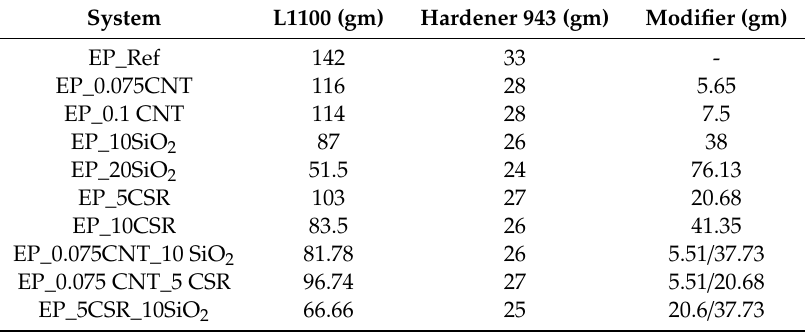
Table 1. Nomenclature and composition of bulk epoxy-based composites. In notation (EP_x Y) EP denotes the reference epoxy / hardener system and x represents the wt. % used, and Y represents modifier, i.e. filler and dispersing DGEBA or